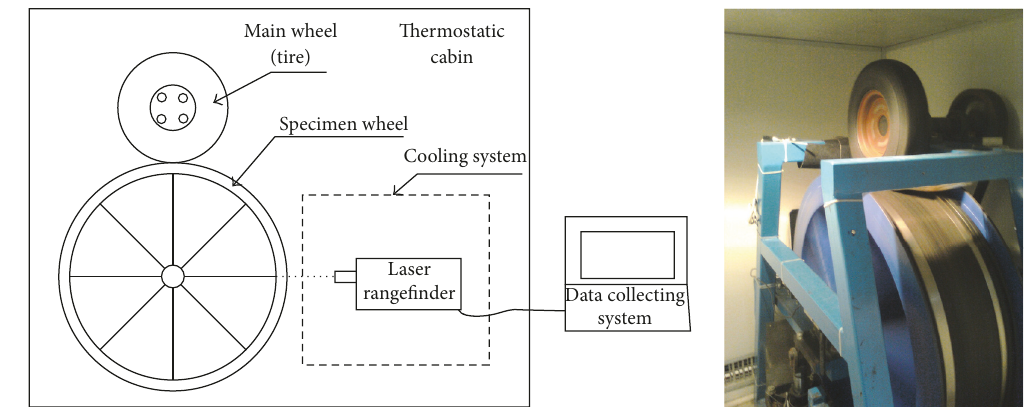
Figure 1: DWPA rutting test